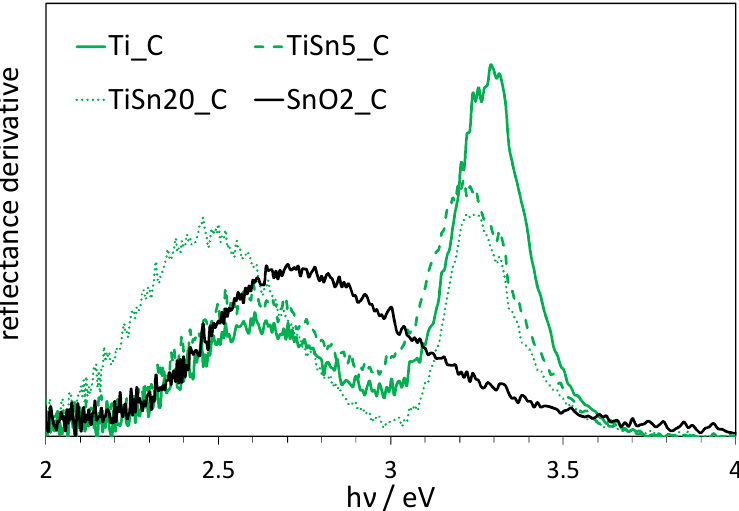
Figure 6. First derivative of reflectance spectra of calcined samples as a function of radiation energy (in eV).